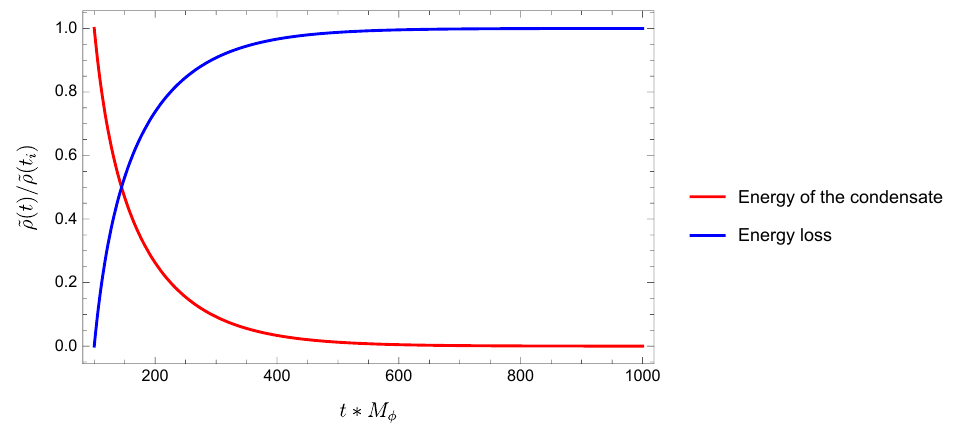
Figure 9 . Energy transfer from the condensate to the produced particles in a radiation-dominated universe. The evolution of the condensate comoving energy density and of the energy loss are shown in the blue and red lines,